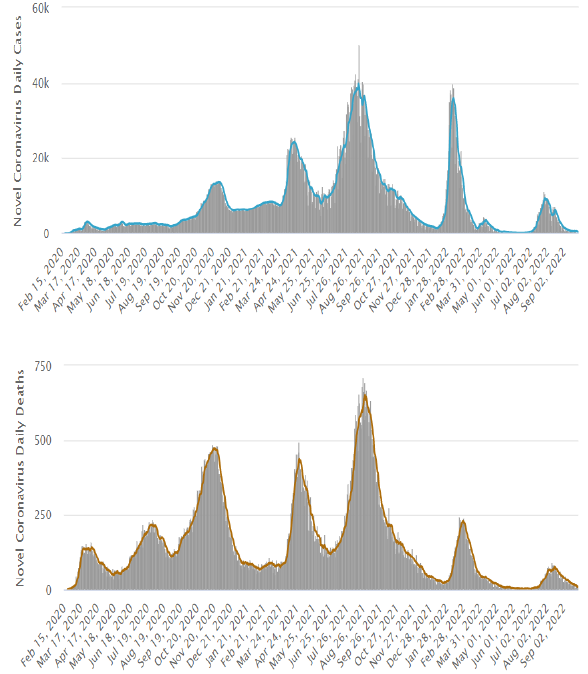
Figure 2 . COVID-19 case load (upper graph) and mortality (lower graph) as of September 5, 2022 in